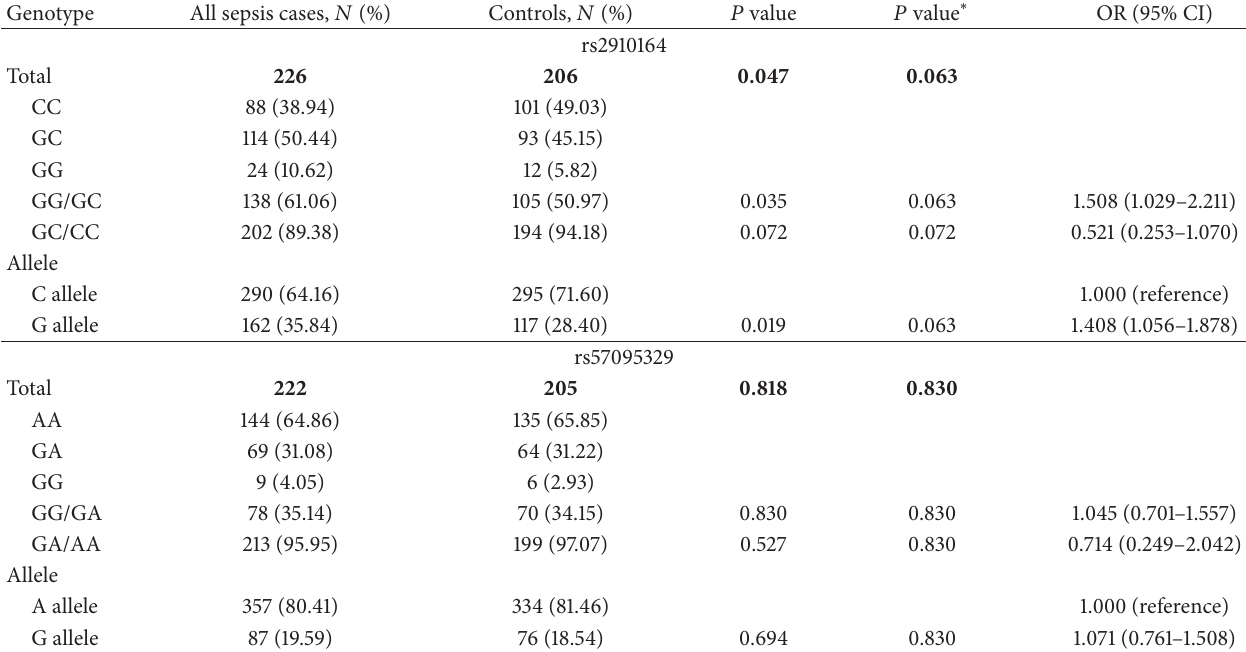
Table 2: Genotype and allele frequencies distribution in patients with sepsis and controls.